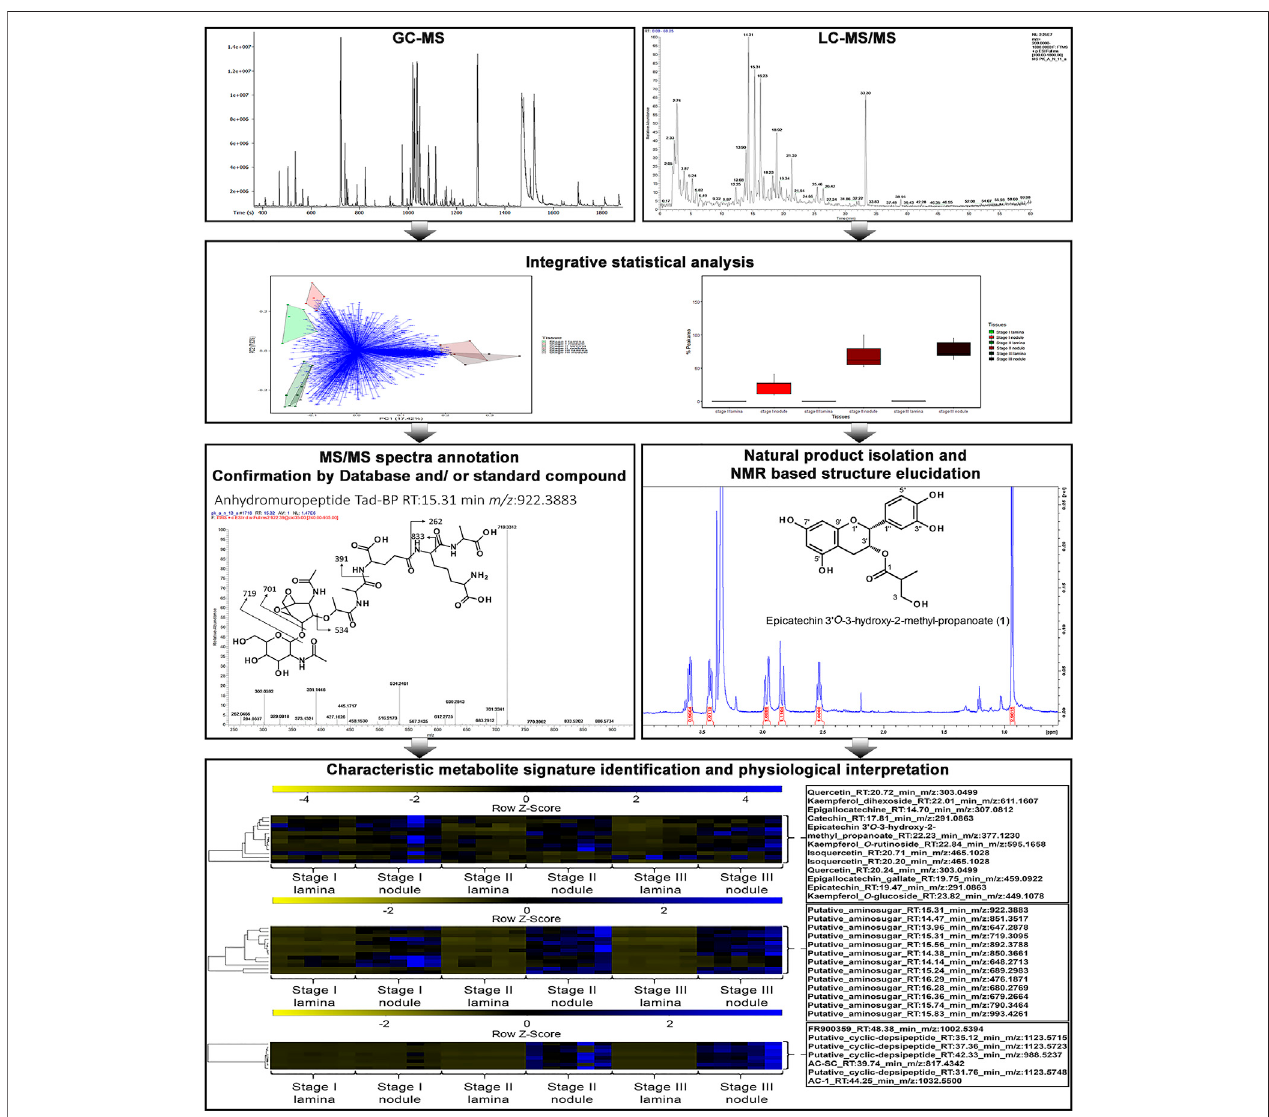
FIGURE2| Overviewforthework fl owutilizingacombinedGC-MSandLC-MSplatforminadditionwithnaturalproductisolationandcharacterisationtodissectthe leaf and leaf nodule metabolism and function in the nodulated species Ardisia crenata and Psychotria punctata .